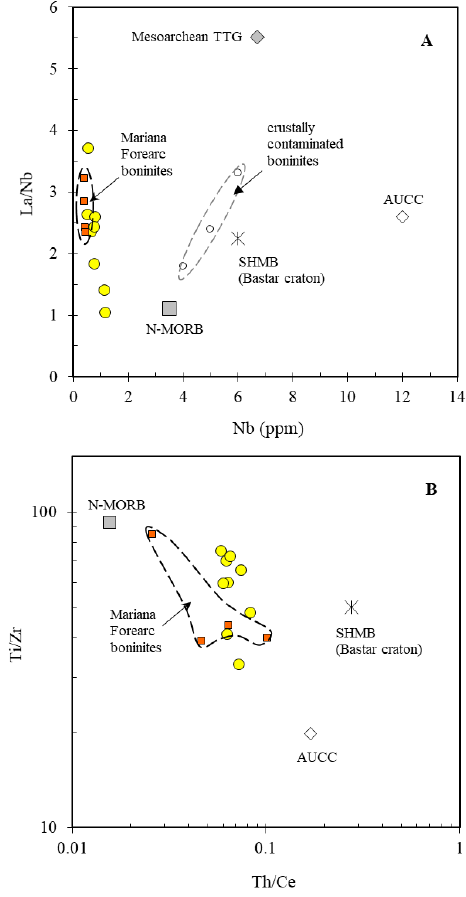
Figure 7. ( A ) Nb vs. La/Nb; and, ( B ) Th/Ce vs. Ti/Zr, bivariate diagrams for the Holenarsipur boninites. Data for Izu-Bonin-Mariana fore arc boninites is from Reagen et al. [2]. Values for N-MORB [28], Archean Upper Continental Crust (AUCC; [29]), crustally contaminated boninites [27], siliceous high-Mg basalts (SHMB; [19]) and Mesoarchean TTG from the Holenarsipur [12], are also shown for comparison. See text for details.